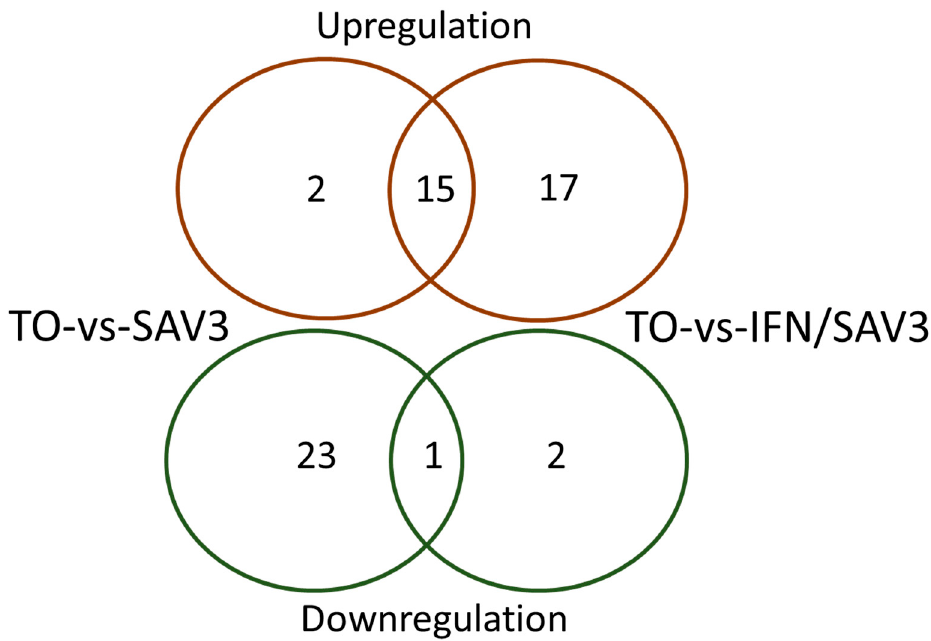
Figure 1. Shows the distribution of upregulated and downregulated unigenes differentially expressed in the TO-vs.-SAV3 and TO-vs.-SAV3/IFN cells involved in the antigen processing and presentation pathway.